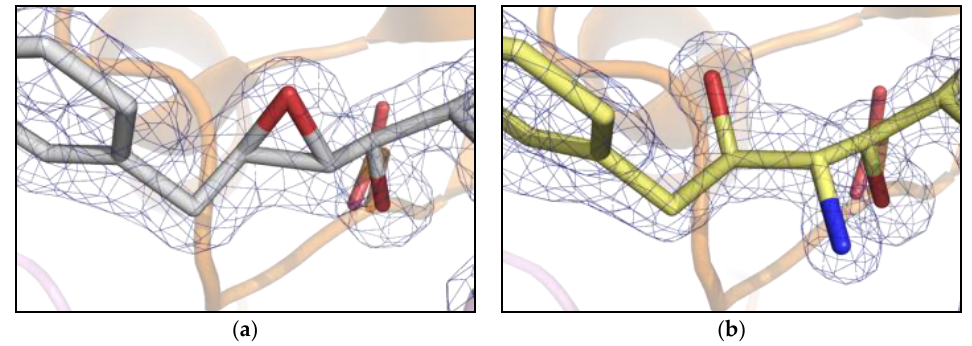
Figure 2. Comparison between electron density 2Fo-Fc maps (contour level 1.2 σ) near the active site of PR (cartoon). ( a ) pH 6.0, pseudopeptide epoxide inhibitor, EPX with unreacted/closed ring and catalytic aspartates in sticks; ( b ) pH 9.0, reacted pseudopeptide epoxide inhibitor showing open epoxide ring and formation of the amino diol derivative.